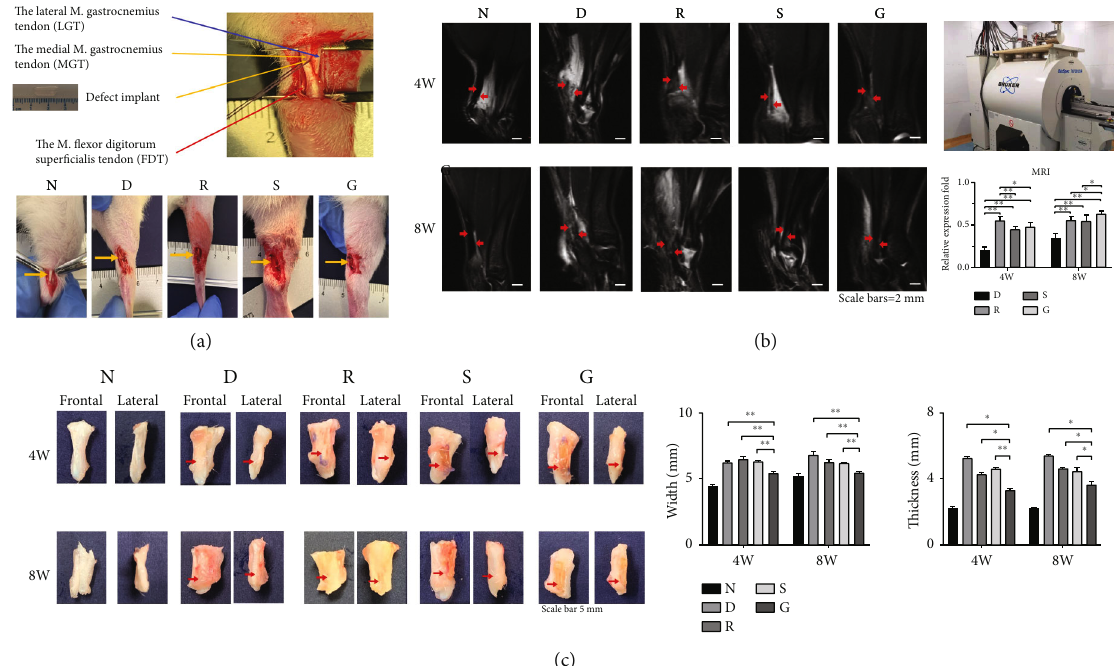
Figure 1: The Achilles tendon defect model and macroscopic repair assessment. (a) Schematic diagram of the anatomy of the rat Achilles tendon and comparison of postoperative surgical areas in di ff erent repair groups. Group N: normal tendon (control group); Group D: defect suture group; Group R: allogeneic replacement repair group; Group S: smooth SF fi lm repair group; Group G: micropattern SF fi lm repair group. (b) MRI comparison of tendon repair after 4 and 8 weeks. The red arrow indicates the repaired area, and the repair signal intensity in group G was signi fi cantly higher than that in other groups at 8 weeks. (c) Comparison of the width and thickness of the Achilles tendon repair samples. The width and thickness of Group G were signi fi cantly lower than those of the other repair